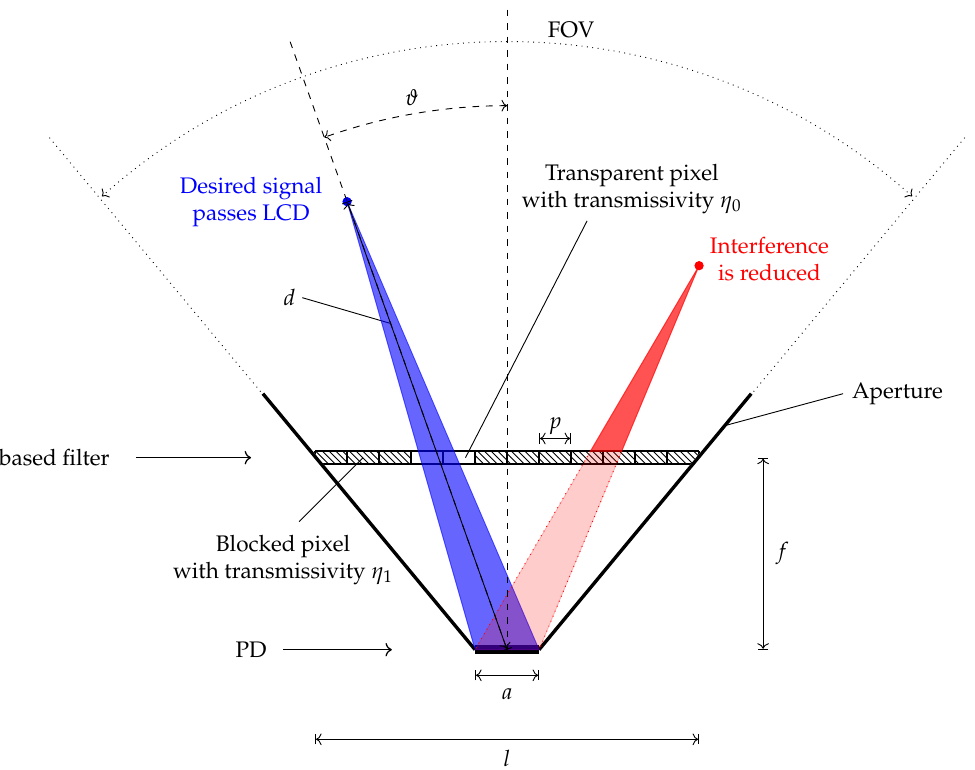
Figure 1. Geometry of detector with the LCD-based